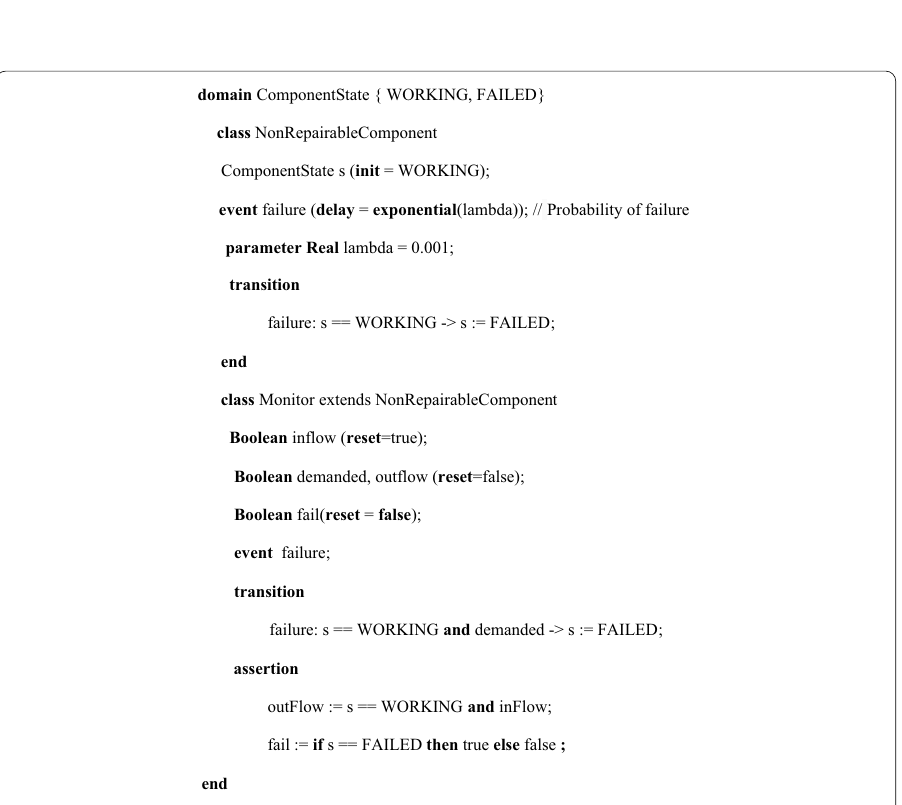
Fig. 11 GTS representing a ranging sensor